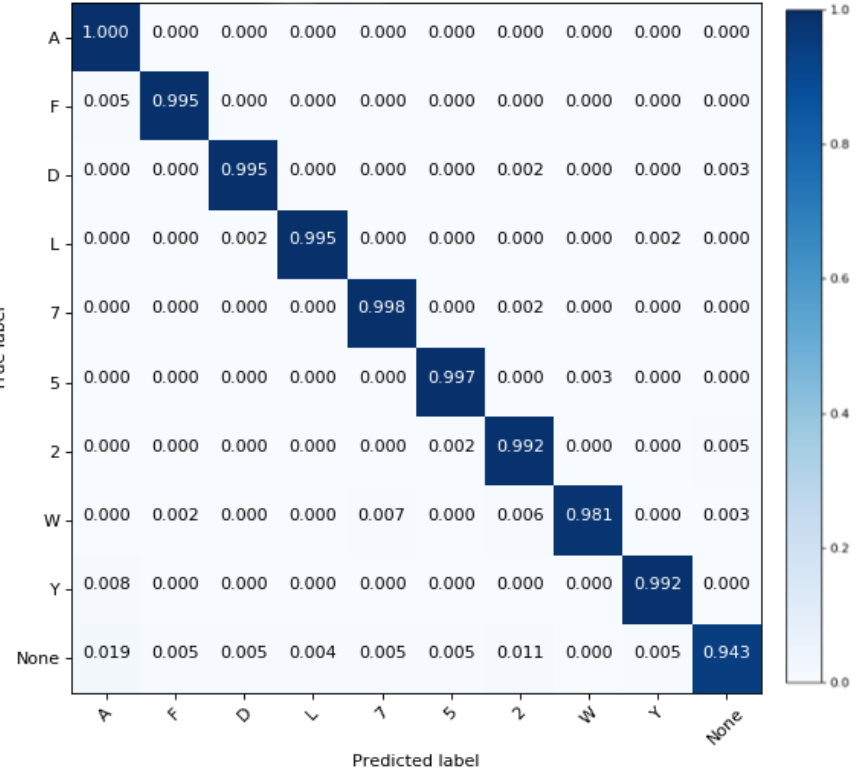
Figure 9. Normalized confusion matrix for our static hand gesture detector quantified on test-set of OpenSign . This figure is taken from [11] with the authors’ permission.